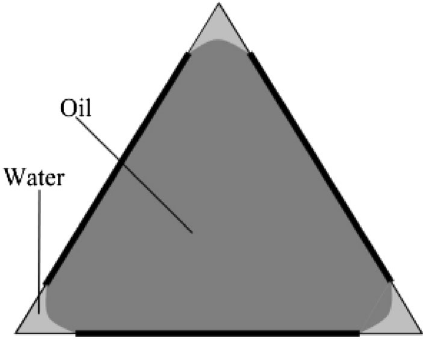
Fig. 3 The glass micromodel and holder used by Soo and Radke for micromodel study